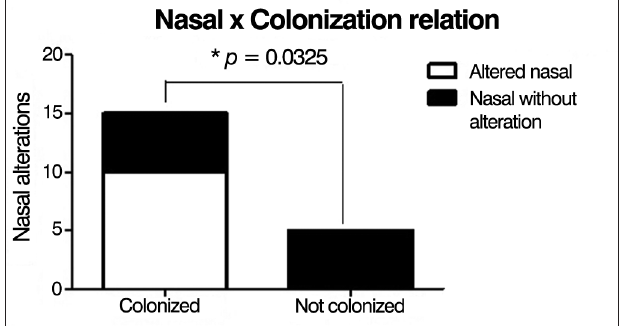
Figure 6. Correlation between chronic lung colonization and nasal endoscopic changes.